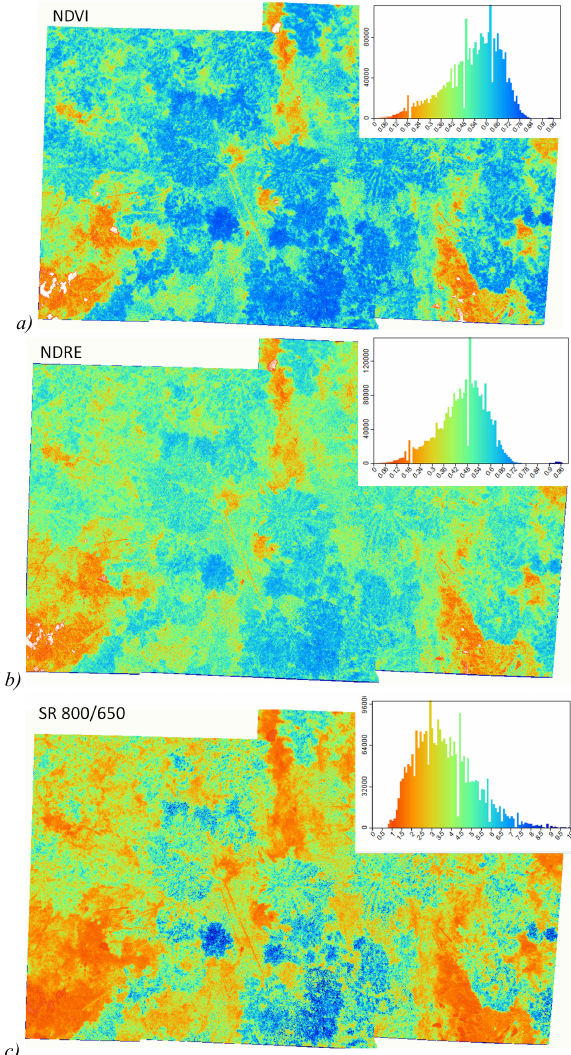
Figure 6. Spatial distribution of NDVI (a), SR 800/650 (b) and NDRE (c) indices over the study